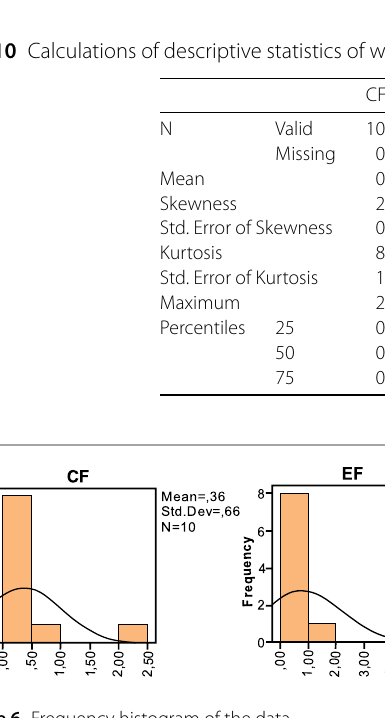
Figure 6 Frequency histogram of the data